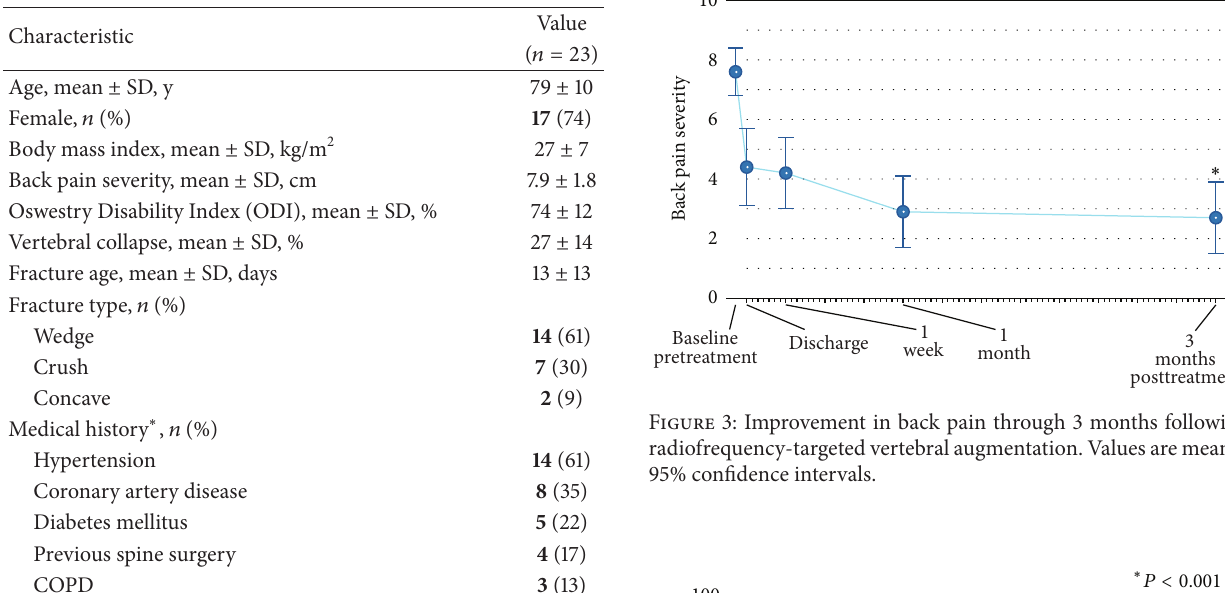
Table 1: Patient baseline characteristics.